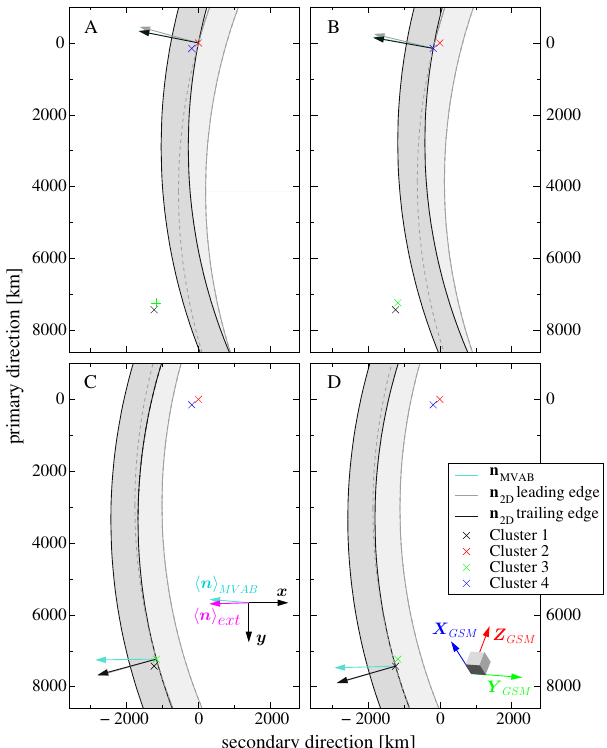
Fig.10. The2-D,non-planarMPmotionintheplaneperpendiculartotheinvariantdirection,accordingtothe Fig. 10. The 2-D, non-planar MP motion in the plane perpendicular C2 OpTA B solution. Foradescriptionofthispictureseethetext. to the invariant direction, according to the C2 OpTA B solution. For a description of this picture see the